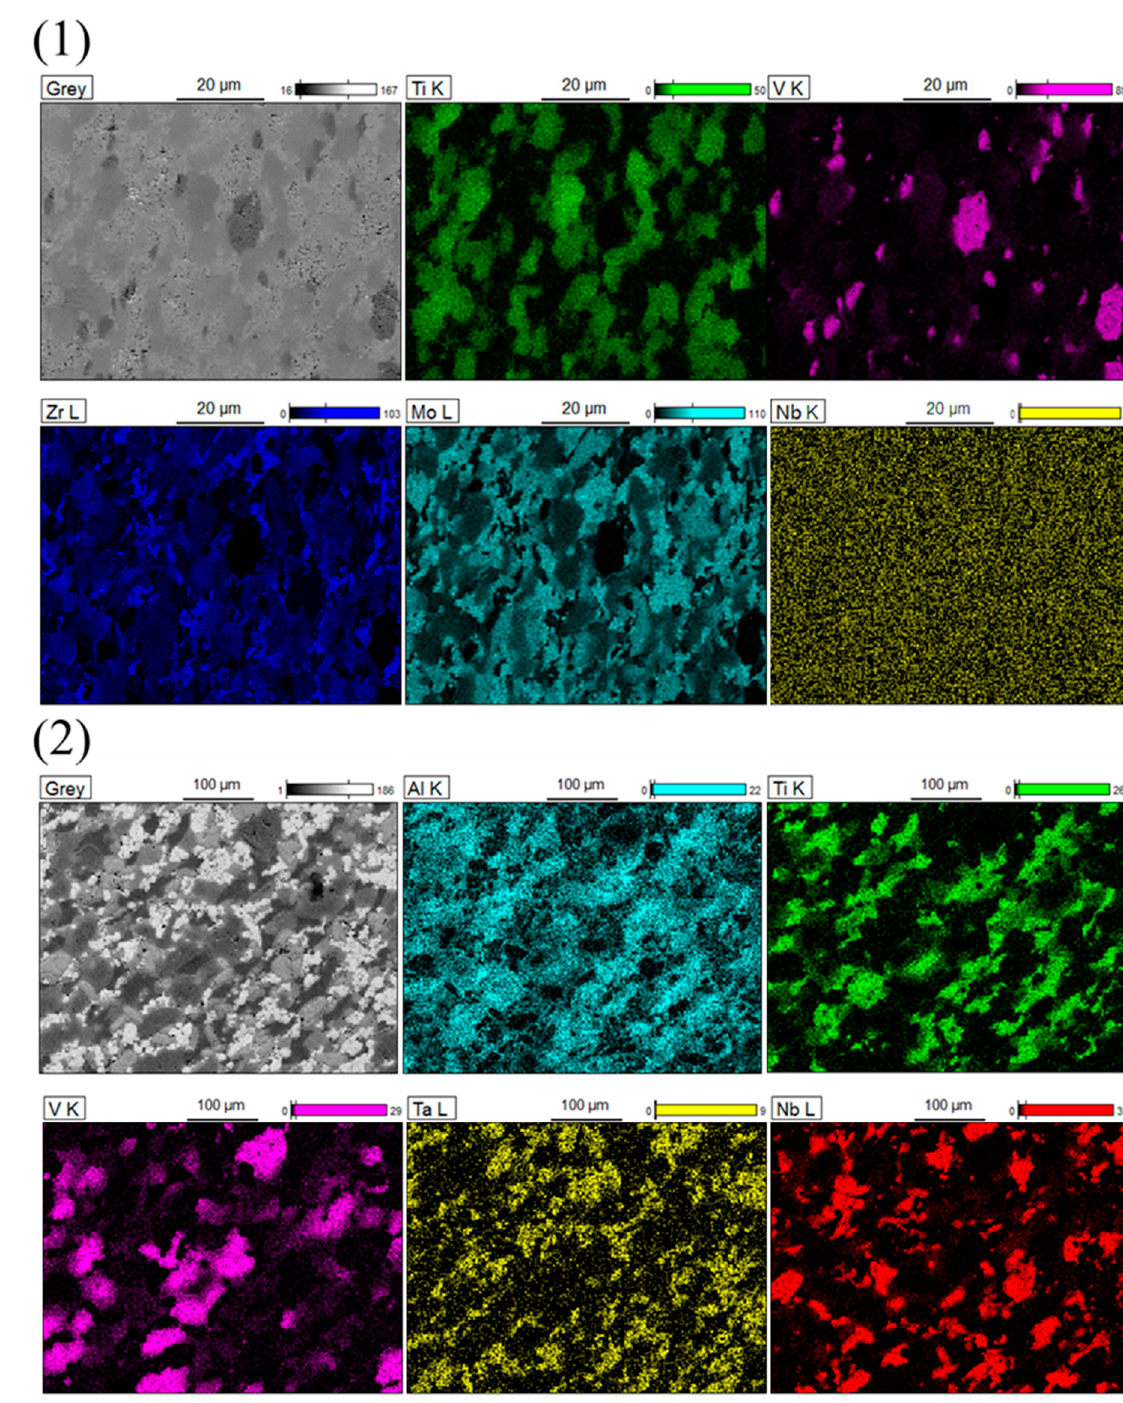
Figure 3. ( 1 ) EDS analysis of the TiZrNbMoV alloys elemental distribution; ( 2 ) EDS analysis of the NbTiAlTaV alloys elemental distribution.